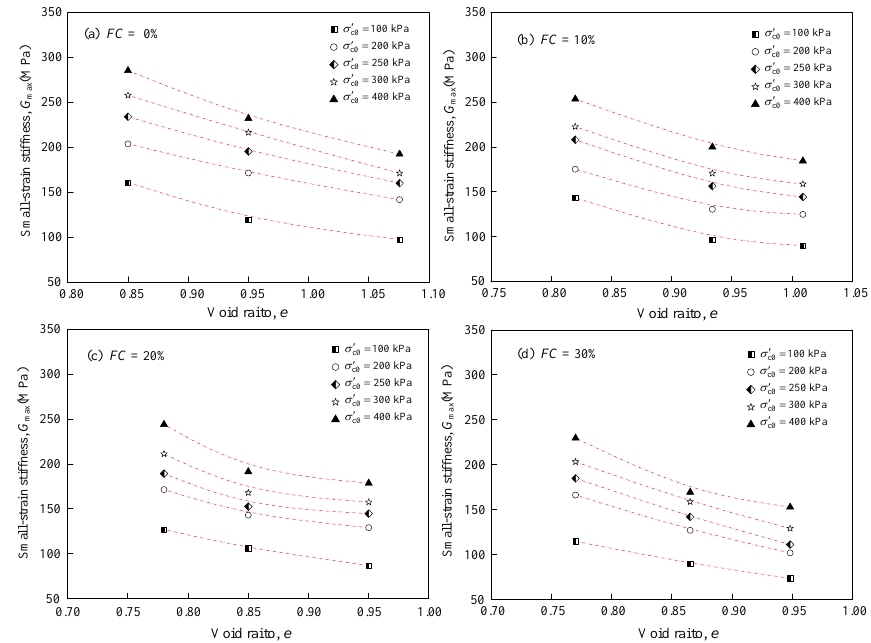
Figure 4. The relationship between G max and e for Nantong marine silty sand with different FC : ( a ) FC = 0%; ( b ) FC = 10%; ( c ) FC = 20%; ( d ) FC = 20%.